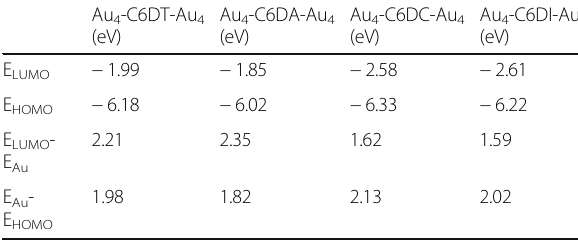
Table 1 Energy levels of the frontier orbitals of molecules contacting with four Au atoms computed by DFT